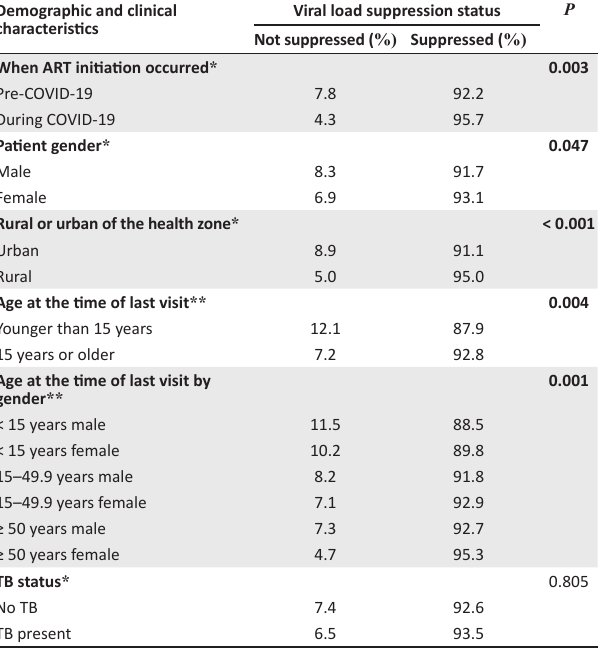
TABLE 3: Bivariate analysis of demographic and clinical factors associated with viral load suppression (< 1000 copies/mL) among patients receiving antiretroviral treatment ( N = 6596).